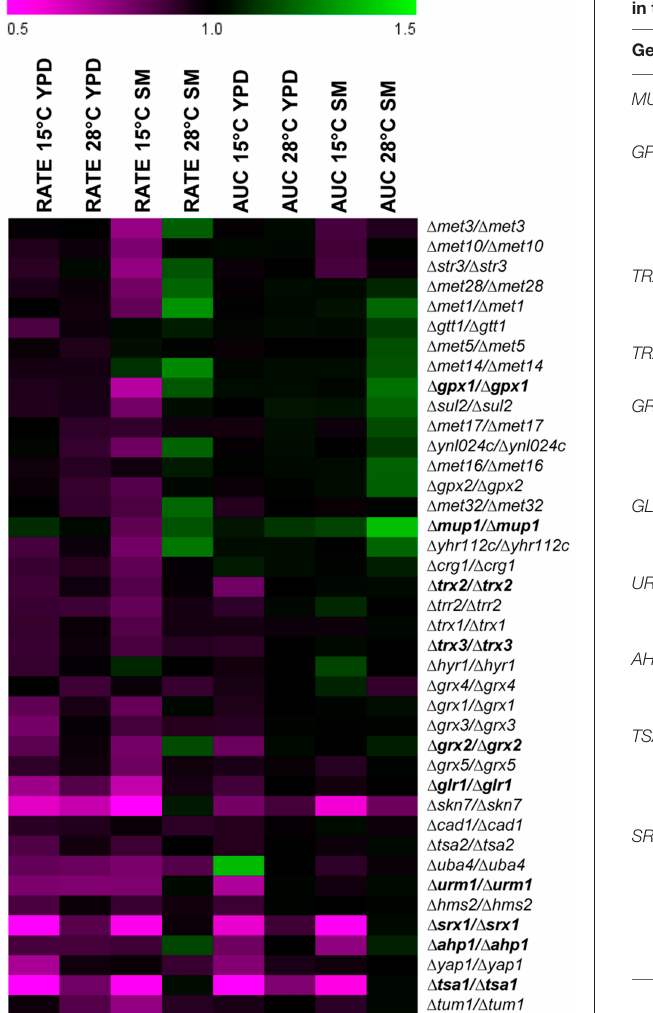
(P5 and P24) were selected that displayed divergent behavior.